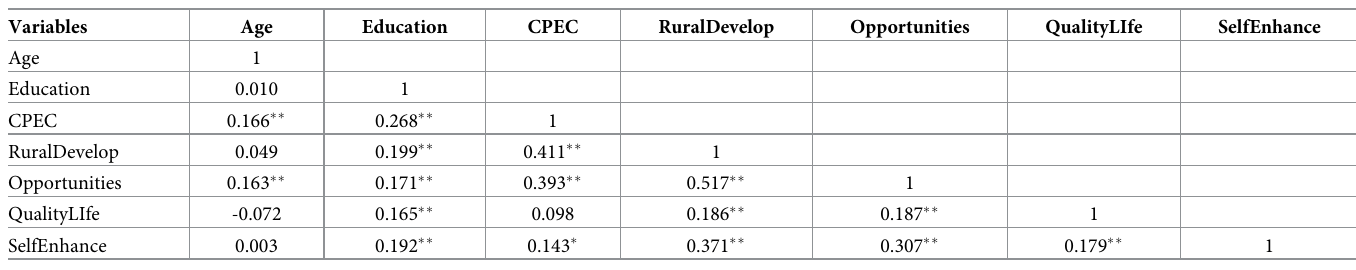
Table 3. Correlations